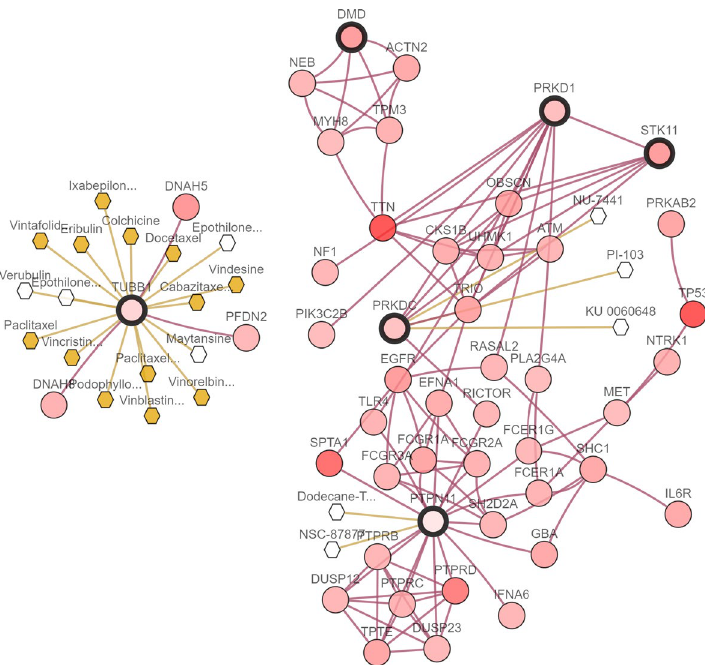
Figure 6. Maximum Integrative Network of features selected by the LogSum + L 2 penalized logistic regression model in GSE19188